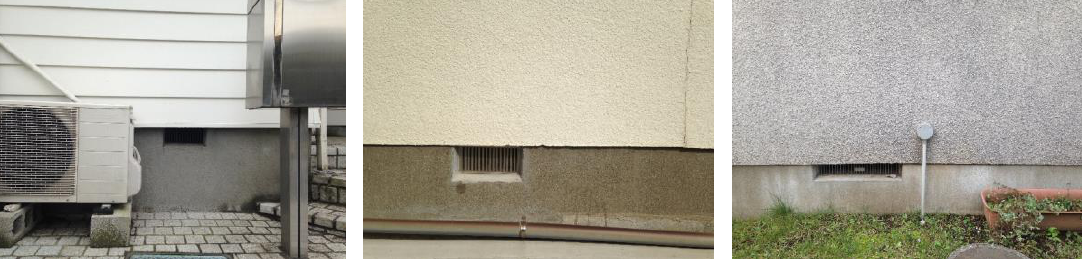
Figure 2. Underfloor openings for the natural ventilation in Tokyo, Japan.